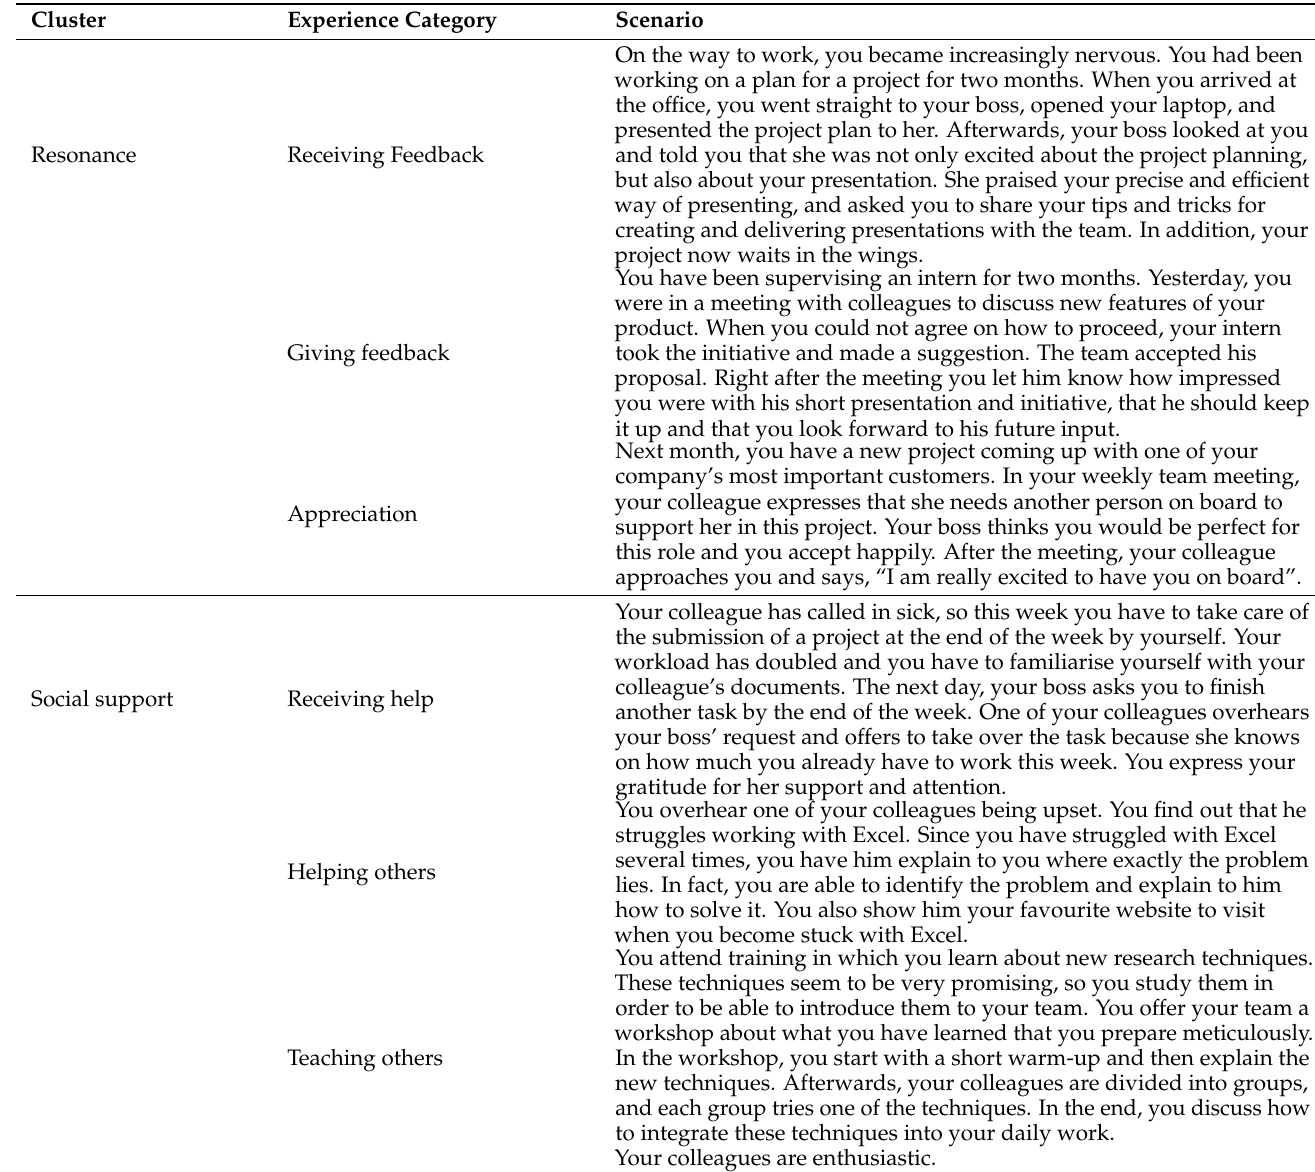
Table A1. Scenarios of the experience categories (Study